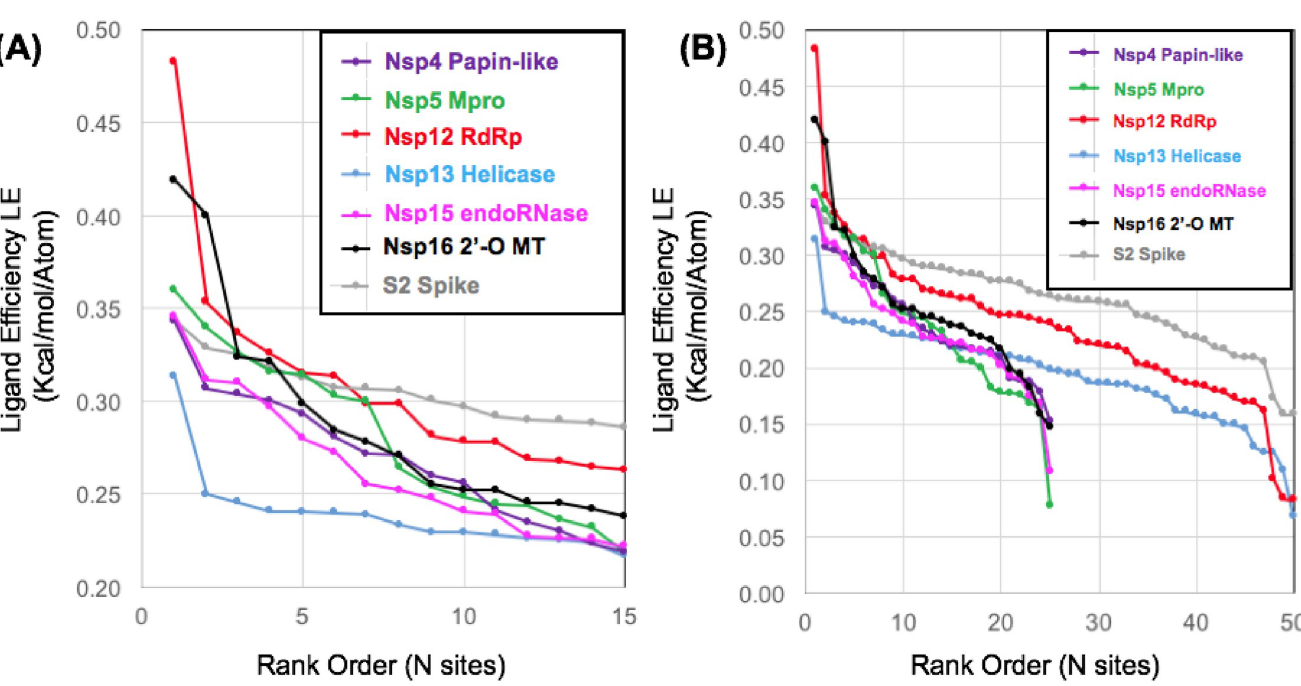
Fig 4. Calculated ligand efficiency comparisons of aromatic pharmacophore sites. The data is shown plotted focusing on the rank order of the first 15 most favorable sites (A) or over all of the sites characterized (B).